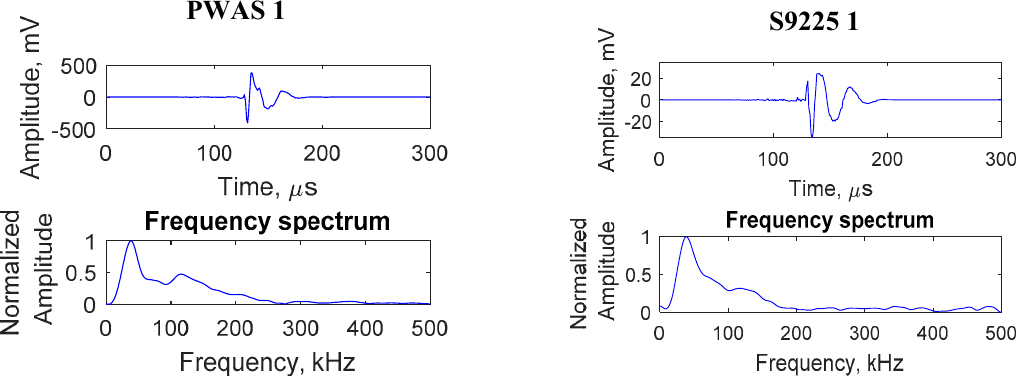
Figure 22. Signals captured by the PWAS 1 and S9225 1 sensors, due to a particular AE event at the crack.